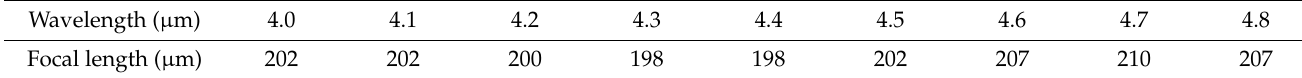
the metalens in the xz-plane at wavelengths from 4.0 μm to 4.8 μm (spaced by 0.1 μm), where z -axis is the optical axis and x -axis is the radial direction of the metalens. Table 2. Focal lengths at wavelengths from 4.0 to 4.8 μm .